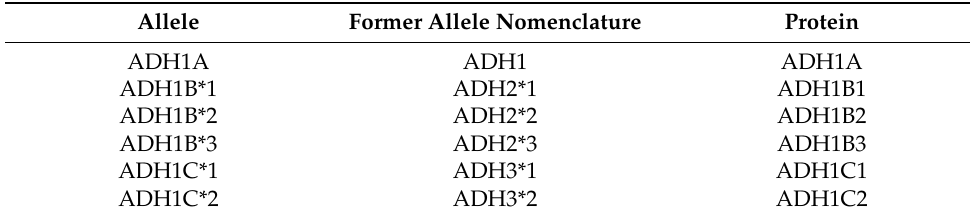
Table 1. Nomenclatures for human class I ADH variants a .